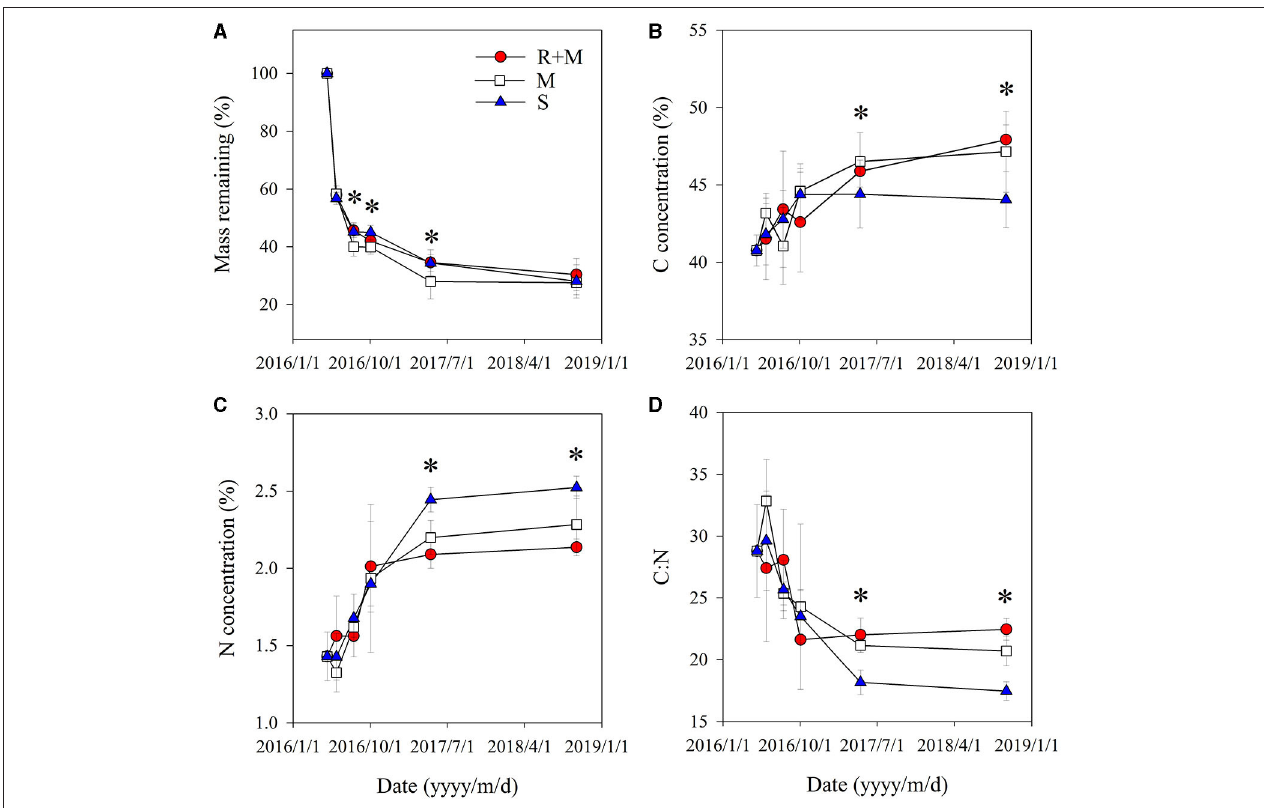
FIGURE 3 | Fine root traits of A. halodendron during decomposition under the following three treatments: fine root and mycelia (R + M), mycelia (M), and bulk soil (S). (A) indicates the dynamic of mass remaining to the initial value; (B) and (C) indicate the changes of carbon (C) and nitrogen (N) concentrations, respectively; and (D ) indicates the change of root C:N ratio. Values represent M ± S D . Values of a parameter on a given date labeled with * differed significantly among treatments ( P <